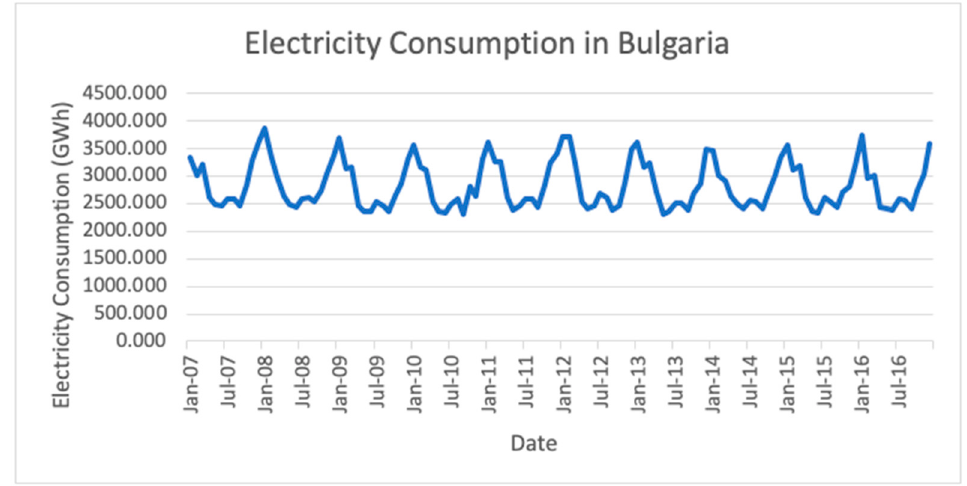
Figure 10. Electricity consumption in Bulgaria from 2007 to 2016.